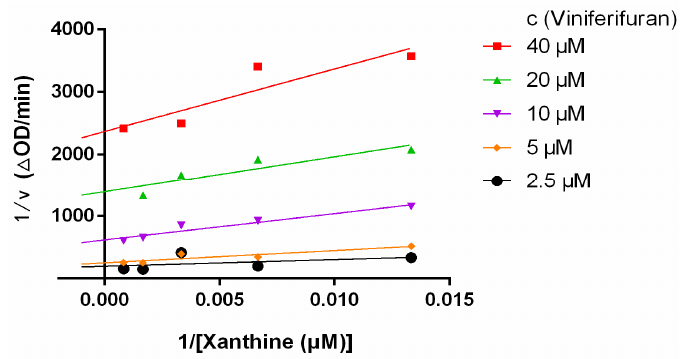
Figure 4. Lineweaver − Burk plots.